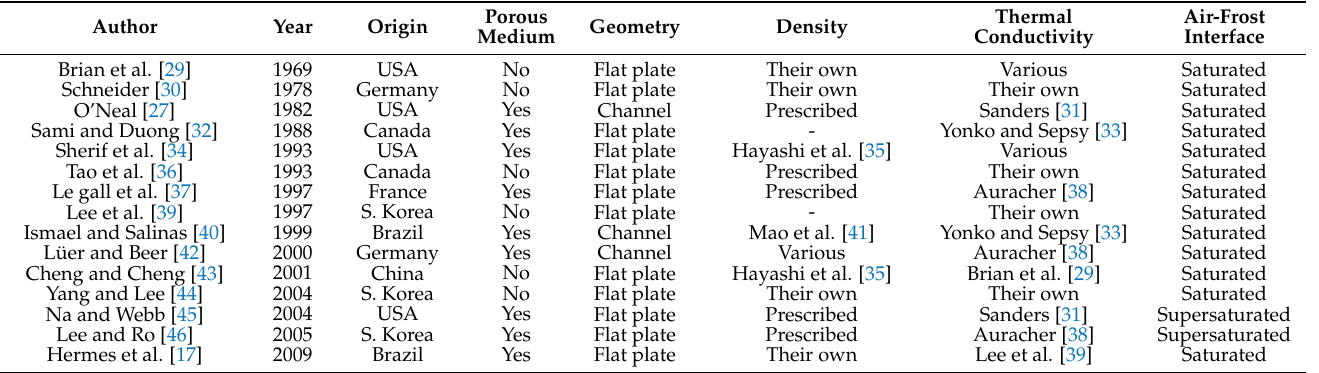
Table 1. Selected works on modeling of frost growth and densification